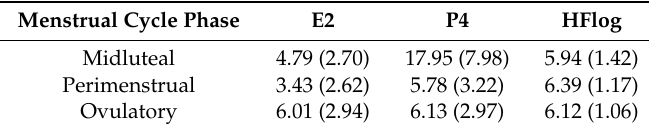
Table 4. Mean and Standard Deviation of Estradiol (E2), Progesterone (P4) and Log High Frequency Heart Rate Variability (HFlog) across the Menstrual Cycle Phases Investigated in Study Two ( N = 112 visits).